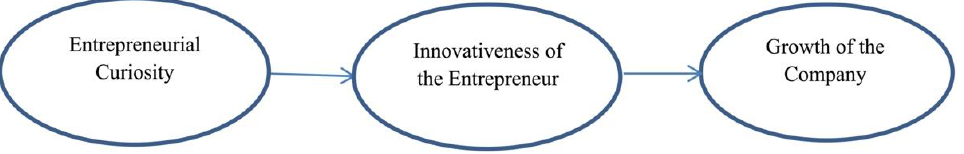
Figure 1. The model of entrepreneurial curiosity, innovativeness, and company